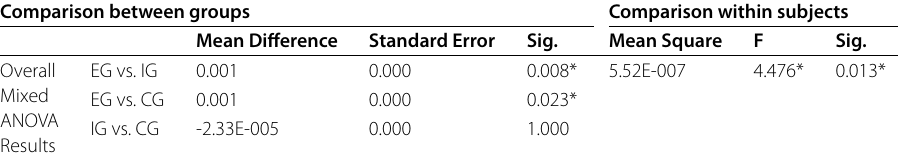
Table 4 Mixed ANOVA results for appeals to shared knowledge (normalized values) Comparison between groups